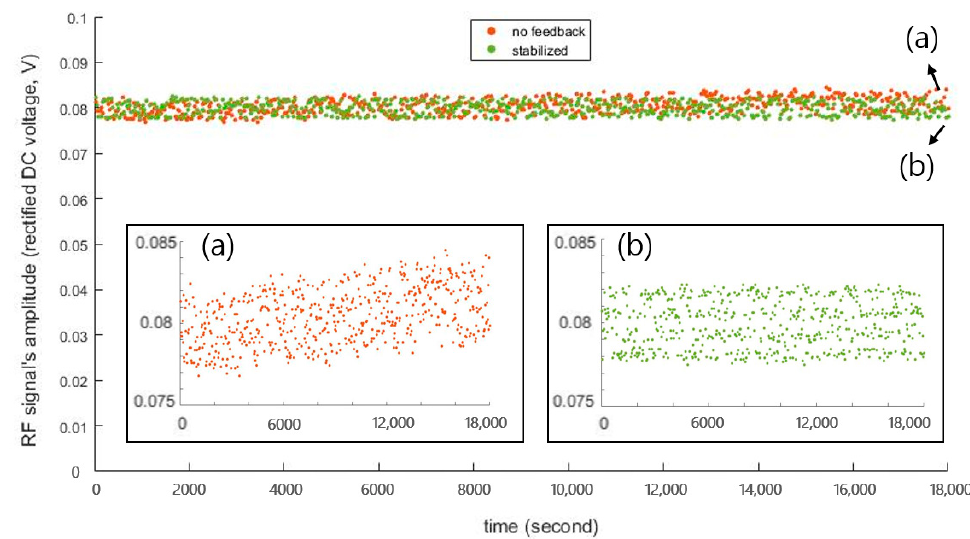
Figure 6. Results of the amplitude of the RF signal for 18,000 s. ( a ) The amplitude of the RF signal without the control. The amplitude drifts from 79.50 to 81.34 mV. ( b ) The amplitude of the RF signal when the FPGA-based PI controller is used. The voltage does not drift. When the FPGA-based feedback controller is used, no overshoot occurs, and the settling time is less than 1 s.